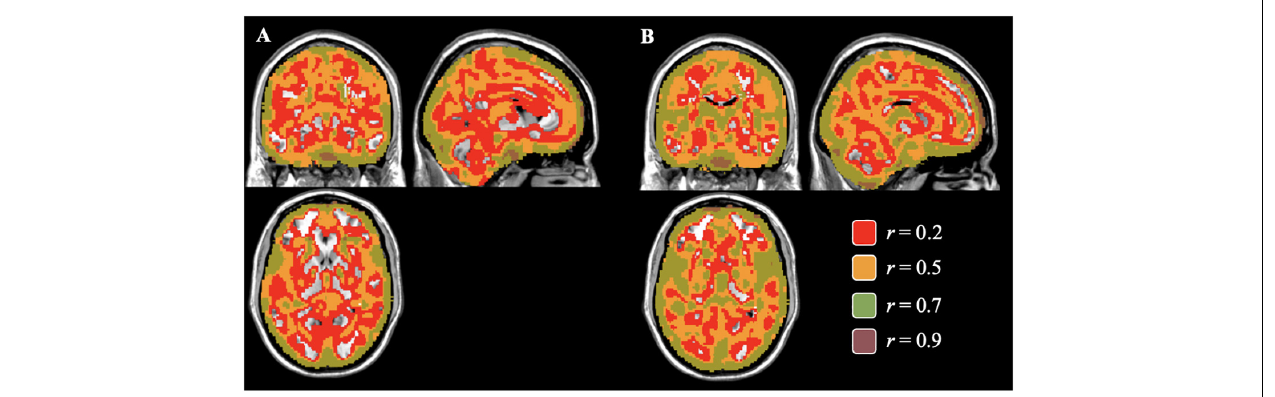
FIGURE 2 | Voxelwise Correlations between Concentration and Volume for Controls (A) and Individuals with Schizophrenia (B) Colored correlations set at different thresholds between gray matter concentration and volume images of healthy controls (A) and individuals with schizophrenia (B) in the brain. The areas of overlap between the concentration and volume results were found mostly in areas of gray matter and gradually decreasing in the subcortical regions as the correlation threshold increases.